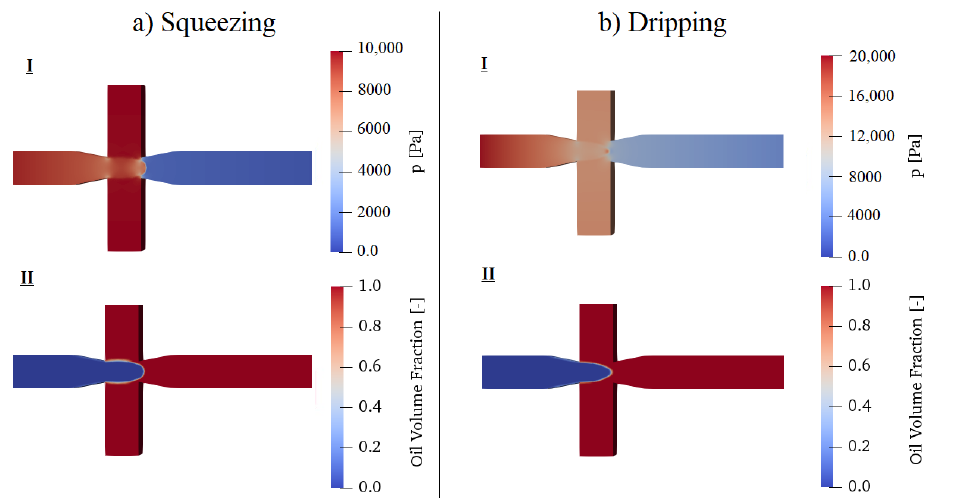
Figure 7. Comparison between droplet formation in ( a ) squeezing ( Ca = 0.005—represented by point A in Figure 6): I. pressure build-up at continuous phase due to junction obstruction, II. oil interface between the two fluids; ( b ) dripping ( Ca = 0.02—represented by point B in Figure 6): I. pressure gradient which is smoother than squeezing, II. oil interface between the two fluids. In both cases, C x =